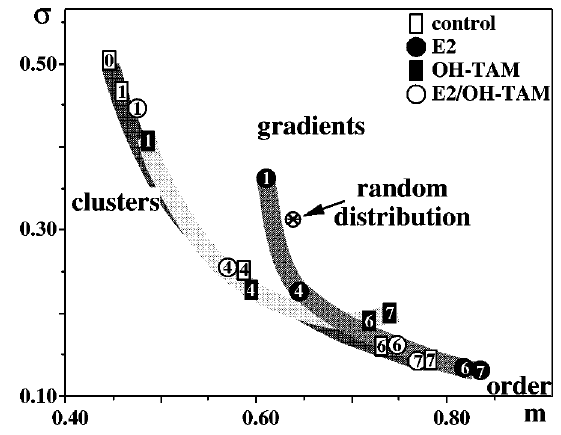
Fig. 6. The ( m , (cid:27) ) plane. The star ( F ) pertains to a perfectly random distribution. If the mean of the experimental results, m , is below that of a random distribution, this is indicative of a tendency to cell clustering. If the value of the standard deviation (cid:27) is above that of the random distribution there is a trend toward gradient formation. Organised distributions are characterised by small values of (cid:27) . The ( 1 ) pertain to control cells, ( " , 2 and ! ) pertain respectively to E2, OH-TAM and E2/OH-TAM treated cells. The duration of the treatments are indicated in the